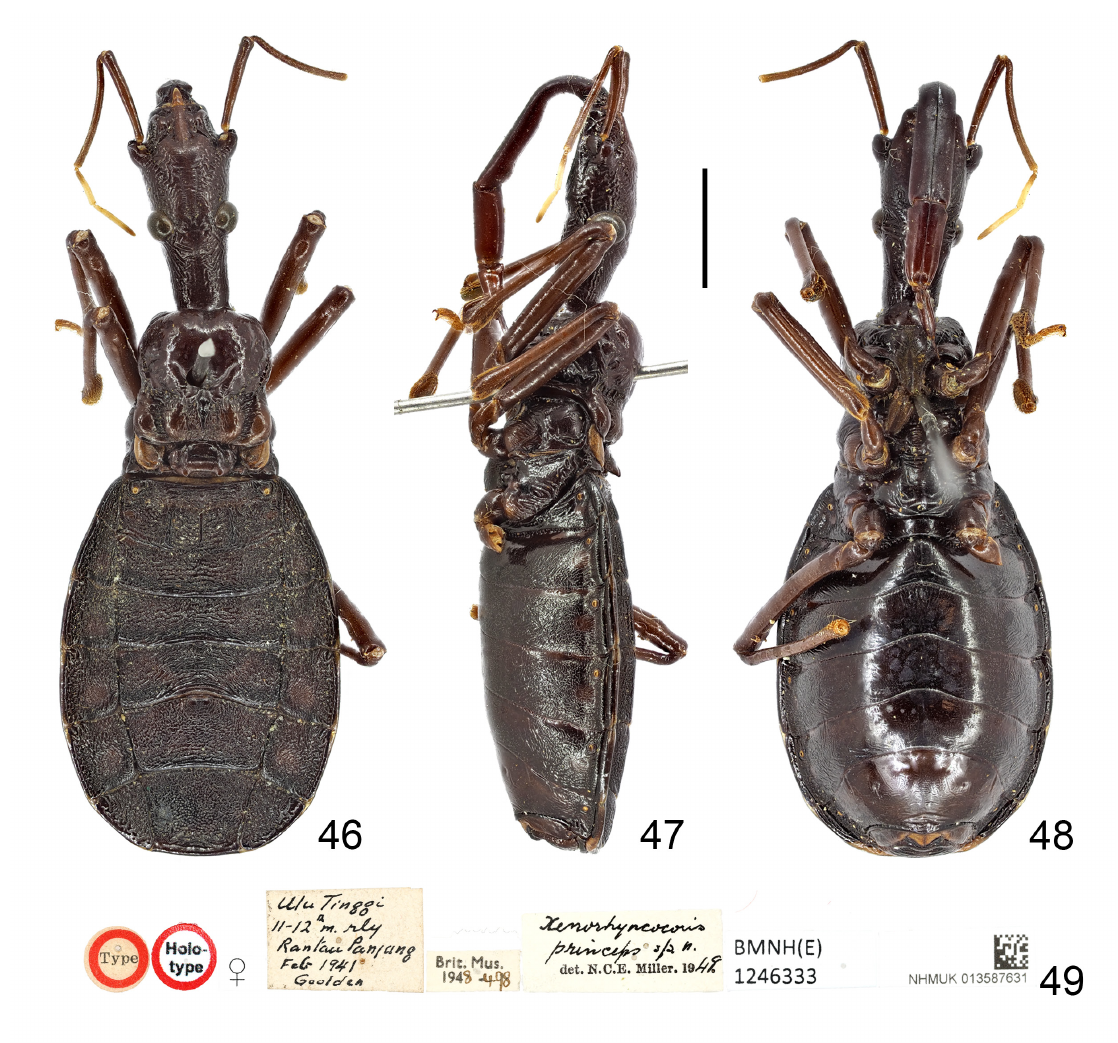
Figs 46–49. Xenorhyncocoris princeps Miller, 1949, holotype, ♀ (NHMUK 013587631), habitus. 46 . Dorsal view. 47 . Same, lateral view. 48 . Same, ventral view. 49 . Labels. Scale bar: 46–48 = 5.00